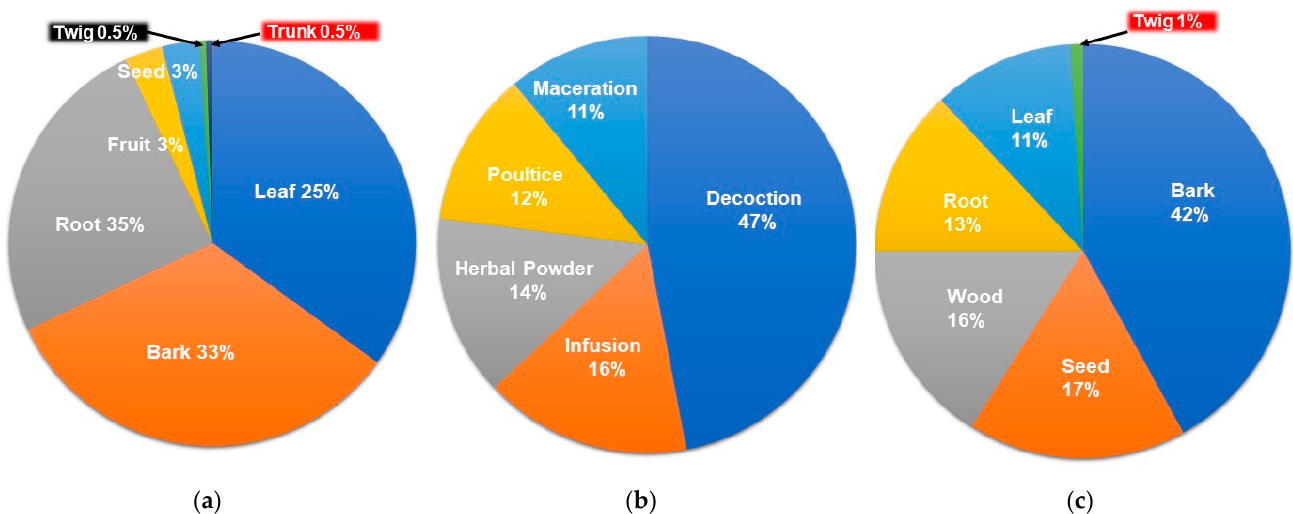
Figure 3. ( a ) Percentage of different plant parts of South African Meliaceae reported to be used in ethnomedicine; ( b ) different dosage forms of herbal remedies of South African Meliaceae reported in the literature; ( c ) plant parts of South African Meliaceae from which compounds were reported to be extracted.